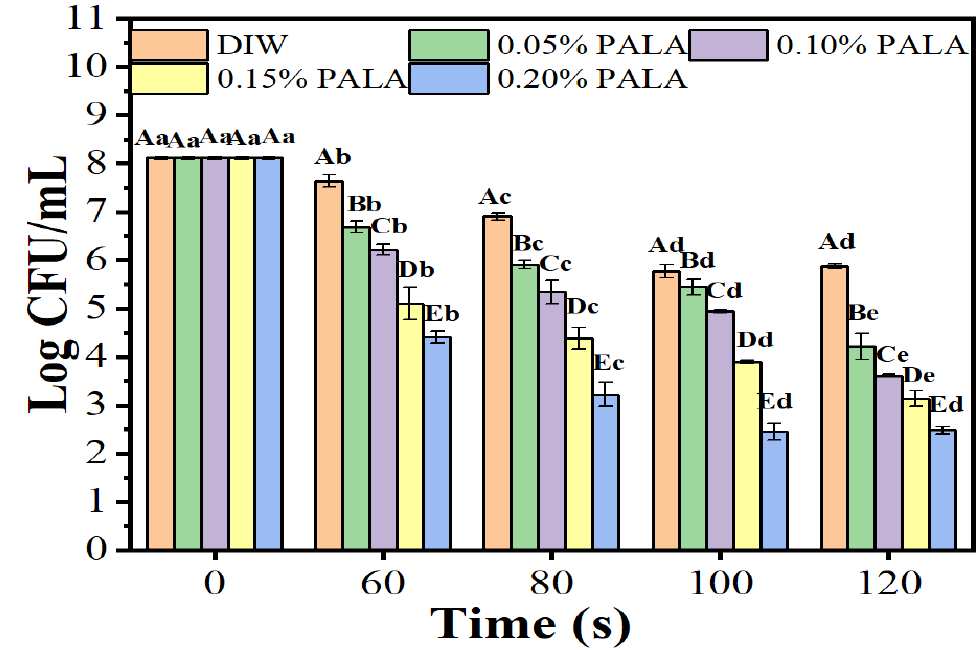
Figure 1. The number of viable cells of P. lundensis incubated for 10 min with deionized water (DIW) and 0.05–0.20% lactic acid (LA) treated with plasma for 0, 60, 80, 100 and 120 s. Error bars represent standard deviation ( n = 3). Different uppercase letters (A–E) indicate a significant difference ( p < 0.05) at the same treatment time over different LA concentrations of PALA. Different lowercase letters (a–e) indicate a significant difference ( p < 0.05) at the same LA concentrations among different plasma jet treatment times with DIW.